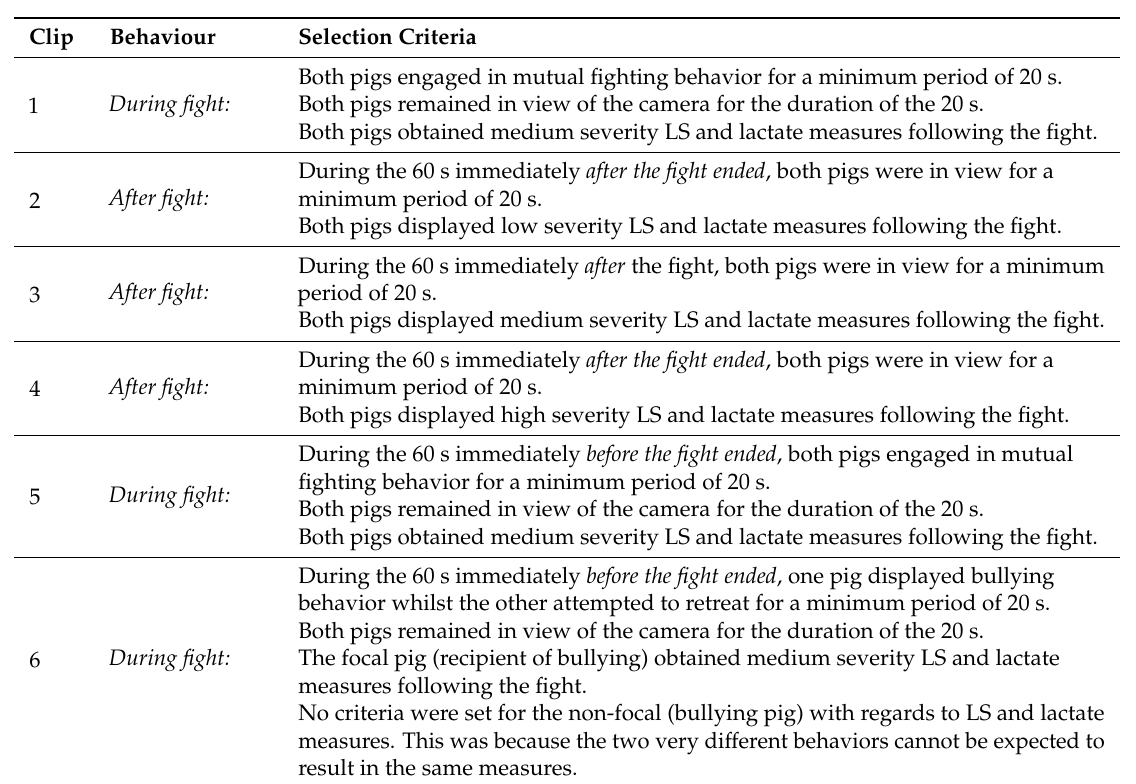
Table A4. Description of video clip selection criteria and content (LS = lesion